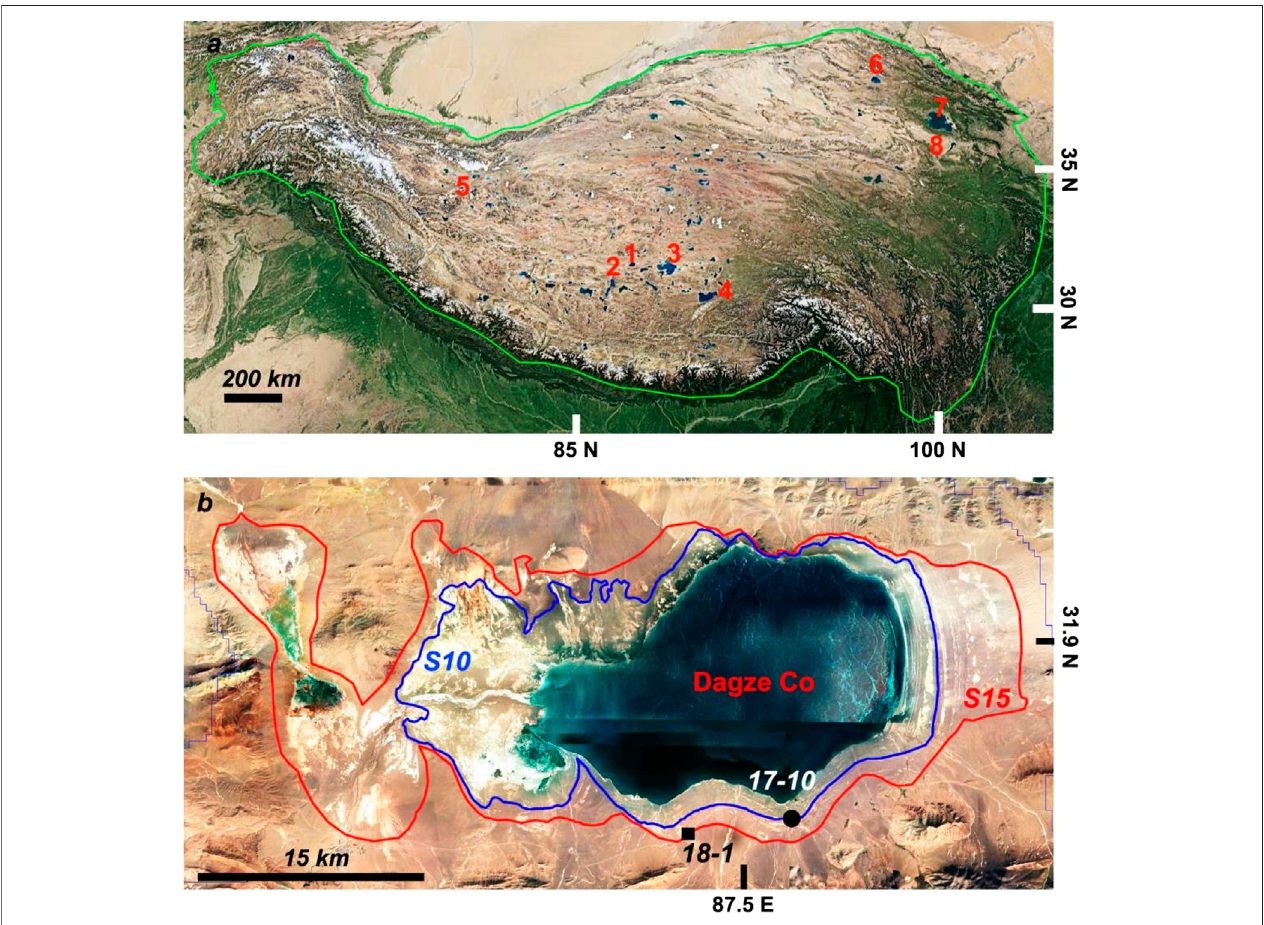
FIGURE 1 | (A) Location of Dagze Co and other lakes mentioned in the text; Dagze Co-1, Dangqiong Co-2, Seling Co-3, Nam Co-4, Longmu Co-5, Hala Lake-6, QinghaiLake-7,DalianhaiLake-8.Thegreen-lineistheoutlineoftheTP. (B) EnlargementshowingDagzeCo.TheblueandredlinesaretheoutlinesoftheLGMandmid- Holocene lake margins, respectively. The black dot and square are the 17 – 10 and 18 – 1 sampling sites. S10 and S15 (the highest in the basin) are high stand paleoshorelines that are 22.4 and 41.6 m higher than present lake level, respectively. Satellite images are from Google-Earth.